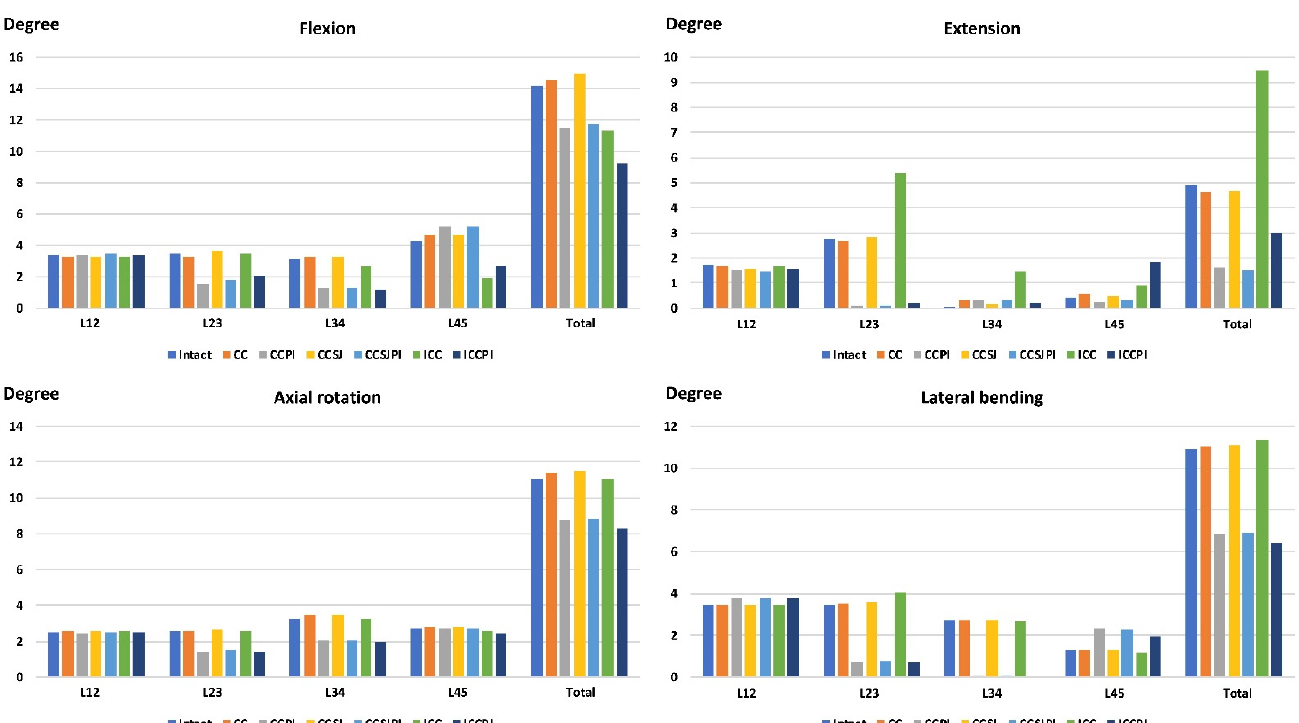
Figure 5. The results of the convergence test ( a ) and force on the facet joint in extension ( b ), axial rotation ( c ) and lateral bending ( d ).